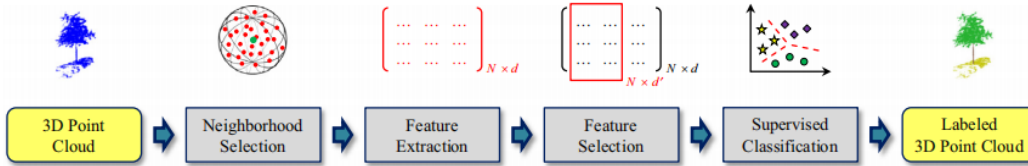
Figure 2. The overview of the point cloud semantic interpretation framework.